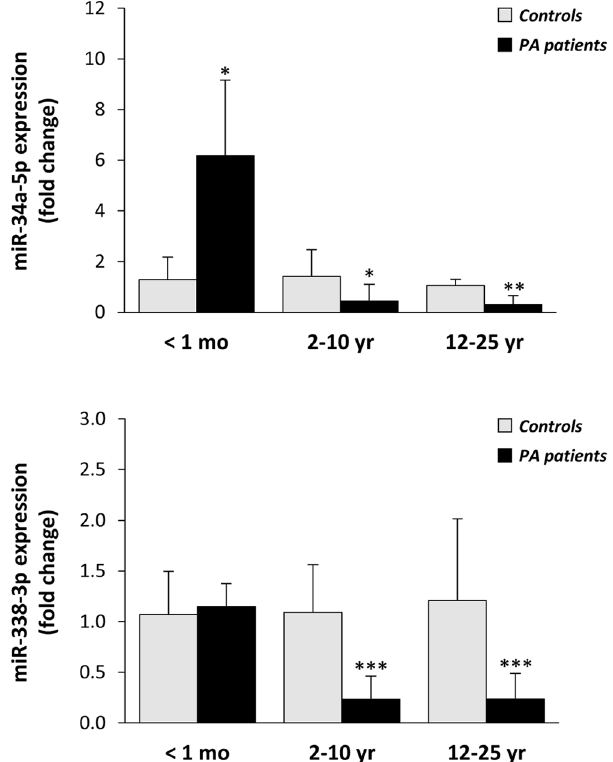
Figure 5. Relative levels of miR-34a-5p and miR-338-3p in plasma samples from PA patients. miRNA analysis was performed by qRT-PCR analysis. PA patient samples and matched controls were grouped according to age: < 1 month-old (n = 8 per group), 2–10 year-old (n = 12 per group) and 12–25 year-old (n = 8 per group). * p < 0.05, ** p < 0.01, *** p < 0.001